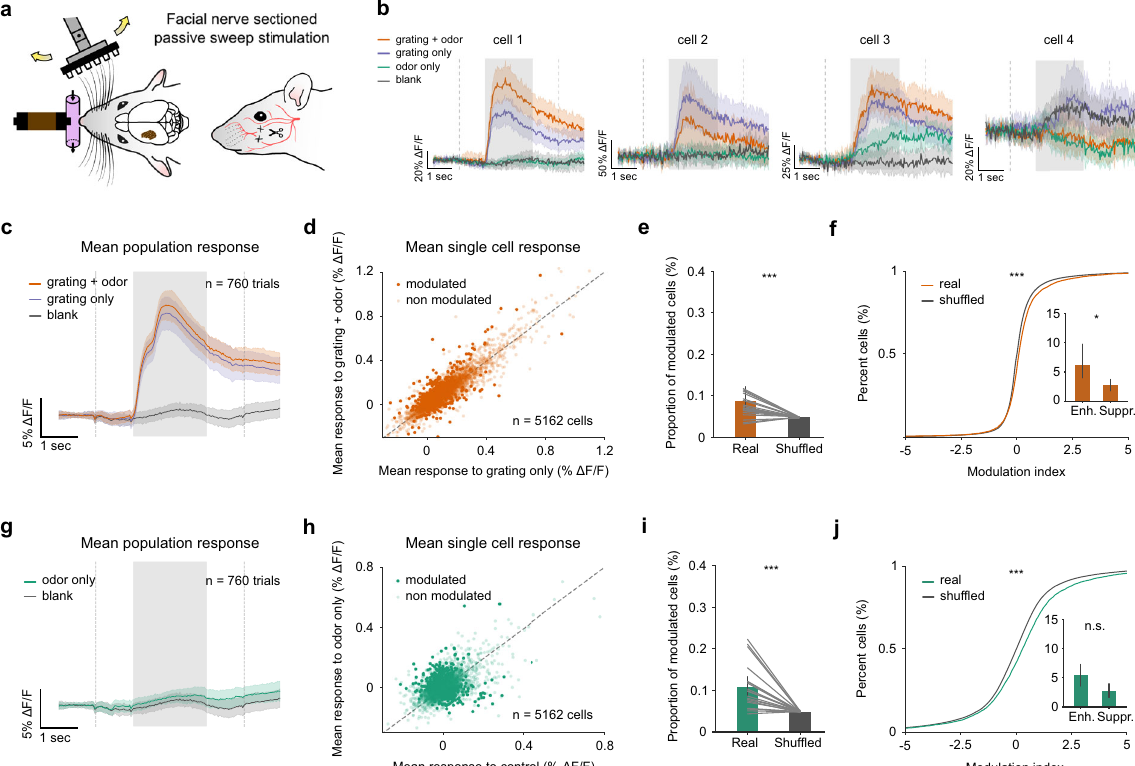
Fig. 4 Odor-induced activity in the barrel cortex persists in the absence of whisking. a Schematic of the stimulation context with facial nerve sectioning. Gratings were brushed against the whiskers in a back and forth sweep. b – j Same as in Fig. 1b – j. b Average Δ F/F for four example neurons displaying diverse odor responses. c Population averages to grating + odor trials (orange) and grating-only trials (blue); average to control (gray) is shown for comparison (mean of bimodal trials = 11.22% Δ F/F (10.78, 11.66); mean of gratings only trials = 10.32% Δ F/F (9.81,10.73); P = 0.001 within sessions; n = 760 trials; Mann – Whitney U test; P = 0.28 between sessions; n = 19 sessions; Wilcoxon signed-rank test). d Scatter plot of mean Δ F/F to grating + odor versus grating onlyfor 5162neurons.Neurons plotted inthe darkare signi fi cantly modulated ( P <0.05,Mann – Whitney U test). Dashedlineindicates diagonal. e Proportionof modulated neurons across sessions compared with shuf fl ed conditions (8.99% (7.79, 10.57) for real data; 4.81% (4.75, 4.87) for shuf fl ed data; P =